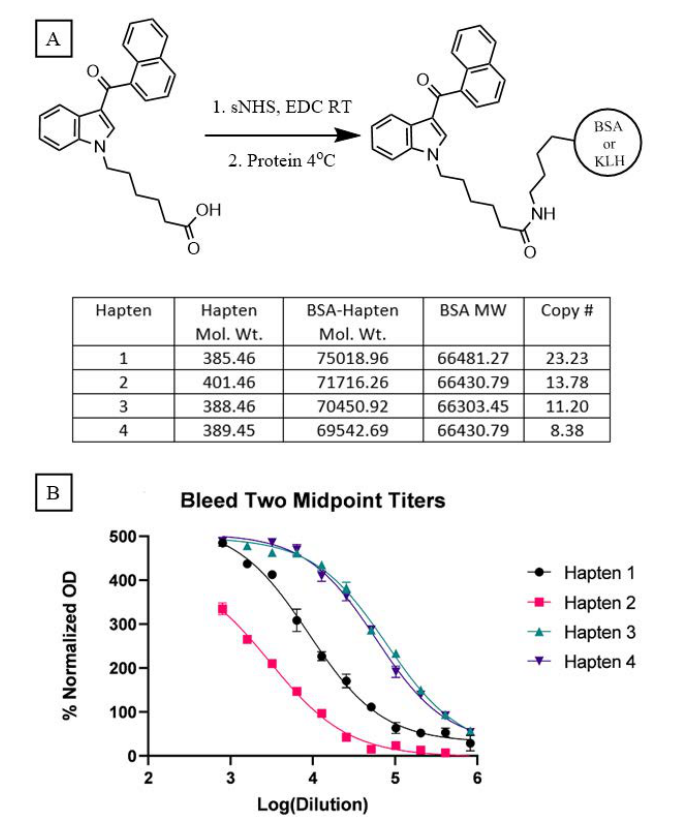
Figure 2. ( A ) Bioconjugation conditions and copy numbers for each hapten. ( B ) Antibody titers from pooled sera collected on day 35. Data shown as mean ±